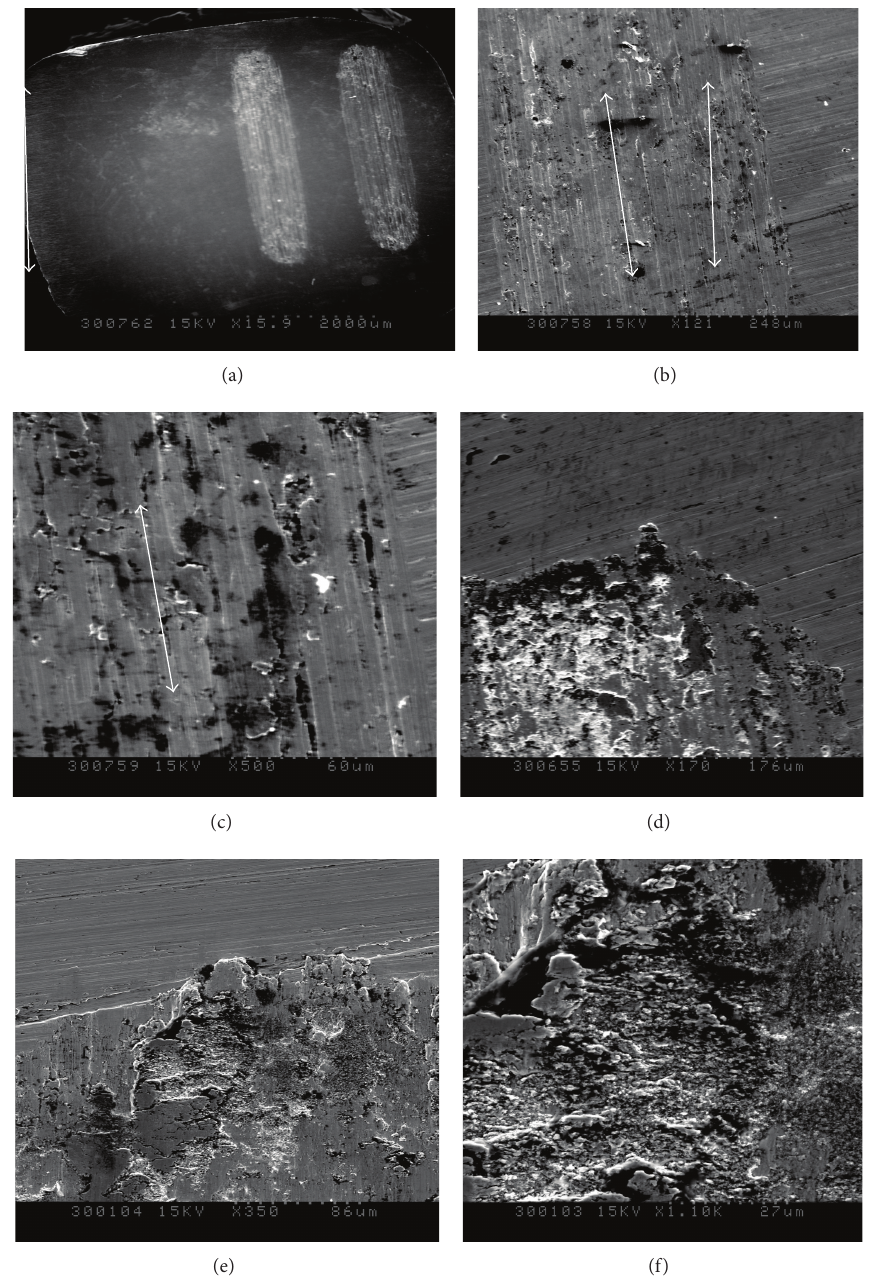
Figure 19: SEM micrographs circular wear marks on Ti-6Al-7Nb sample after the friction test (severe deformation and plastic flow). Arrows indicate the sliding